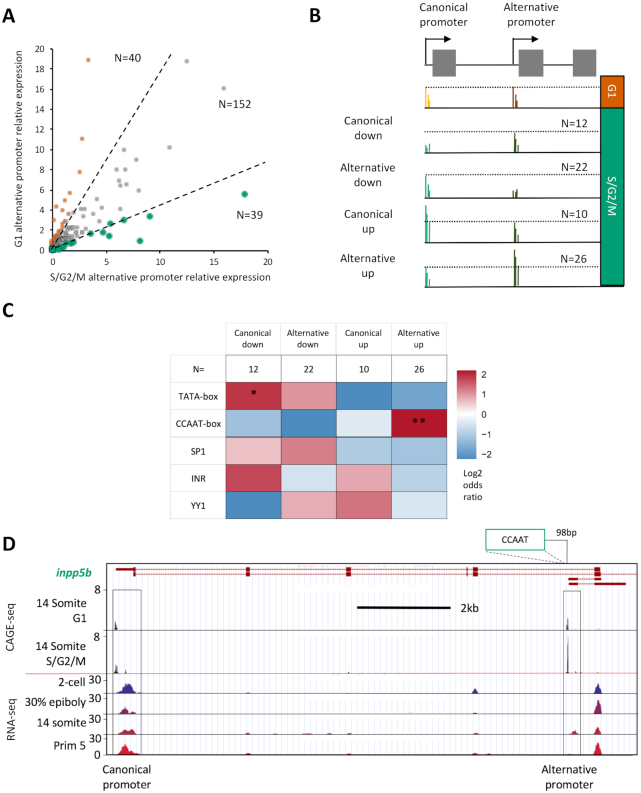
Alternative promoter usage. TPM values were determined for genomic regions identified in Nepal et al. (31) to correspond to canonical and alternative promoters, associated with the same genes (n = 1612). Genes with significant expression (TPM > 5 in either the canonical or alternative promoter region in both the G1 and S/G2/M populations) were taken for further analysis (n = 231). (A) Plot of correlation of alternative promoter utilization, normalized to canonical promoter expression, between G1 and S/G2/M populations. Dashed lines denote threshold of 2-fold change in normalized alternative promoter expression between the populations (n = 79). These differentially utilized genes were segregated by whether a change in the expression of the canonical or alternative promoter, in either population, was responsible for the 2-fold change in the expression of the alternative promoter, normalized to canonical promoter expression. (B) Diagrammatic summary of group selection criteria. In brief, relative to the G1 population; Canonical down: S/G2/M alternative promoter expression unchanged, but canonical expression depleted (n = 12); Alternative down: S/G2/M alternative promoter expression depleted, but canonical expression unchanged (n = 22); Canonical up: S/G2/M alternative promoter expression unchanged, but canonical expression enhanced (n = 10); Alternative up: S/G2/M alternative promoter expression enhanced, but canonical expression unchanged. Situations falling outside of these criteria were discarded (n = 9). Full selection criteria shown in materials and methods. (C) Heatmap visualizing the log2 odds ratio of selected promoter motif occurrence for each group. Occurrence is scored in each group vs. occurrence in the rest of the data set (n = 80) (*P< 0.05, **P< 0.01, ***P< 0.001, Fisher's exact test). (D) UCSC genome browser view of the inositol polyphosphate-5-phosphatase B (inpp5b) promoters with CAGE-seq tracks showing enhanced alternative promoter usage in the S/G2/M population versus G1, an example of a member of ‘Alternative up’ group. The position of a CCAAT motif relative to the alternative promoter is shown. RNA-seq tracks, imported from the ‘Promoterome CAGE and nucleosome positioning’ publicly available trackhub (URL: http://trackhub.genereg.net/promoterome/danRer7/index.html) (17,31) show that this alternative promoter drives a somitogenesis specific transcript.